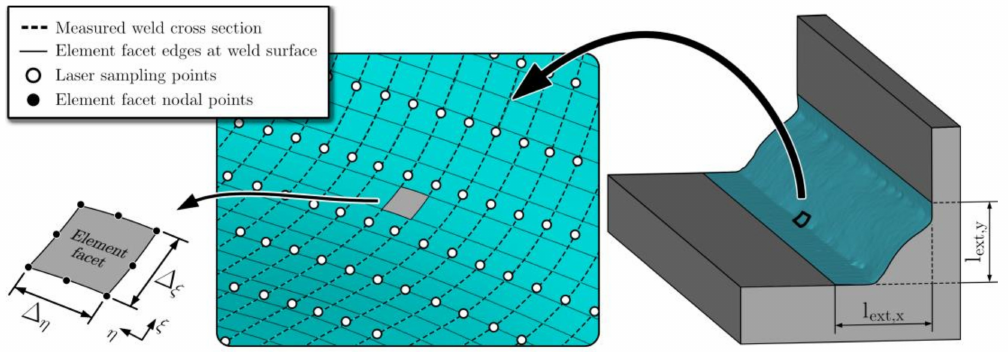
Figure 9. Structured discretisation of the weld geometry